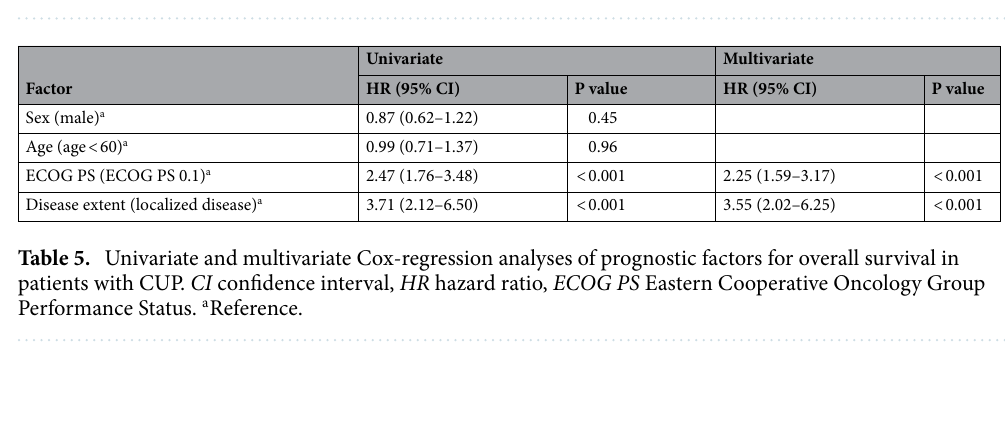
Figure 3. Overall survival according to ( a ) ECOG, ( b ) disease extent, ( c ) histologic groups, ( d ) number of chemotherapy lines.